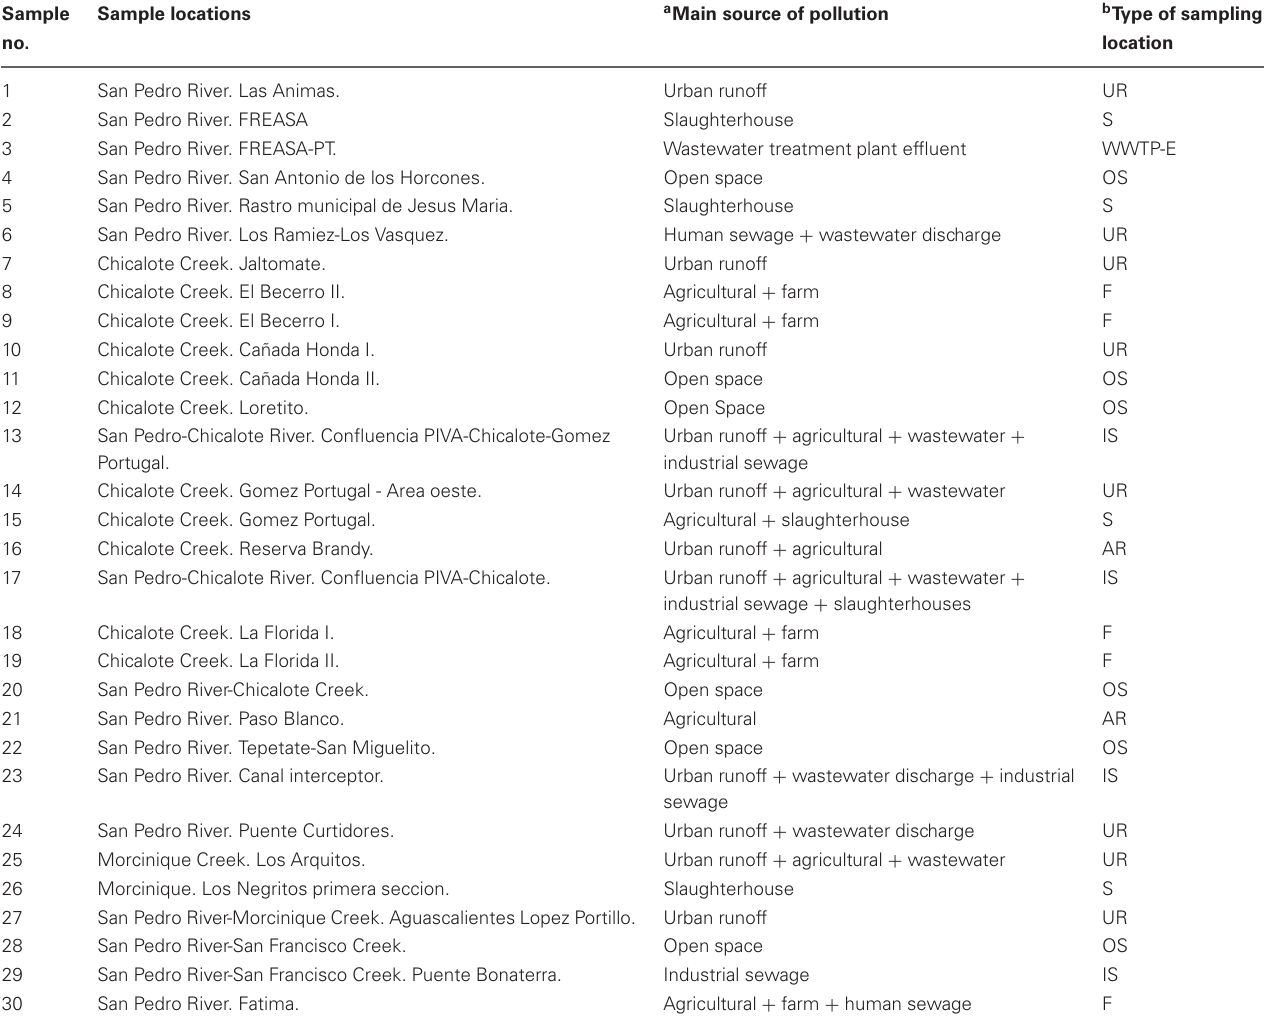
Table 1 | Location and main sources of pollution of the 30 sampling locations studied.